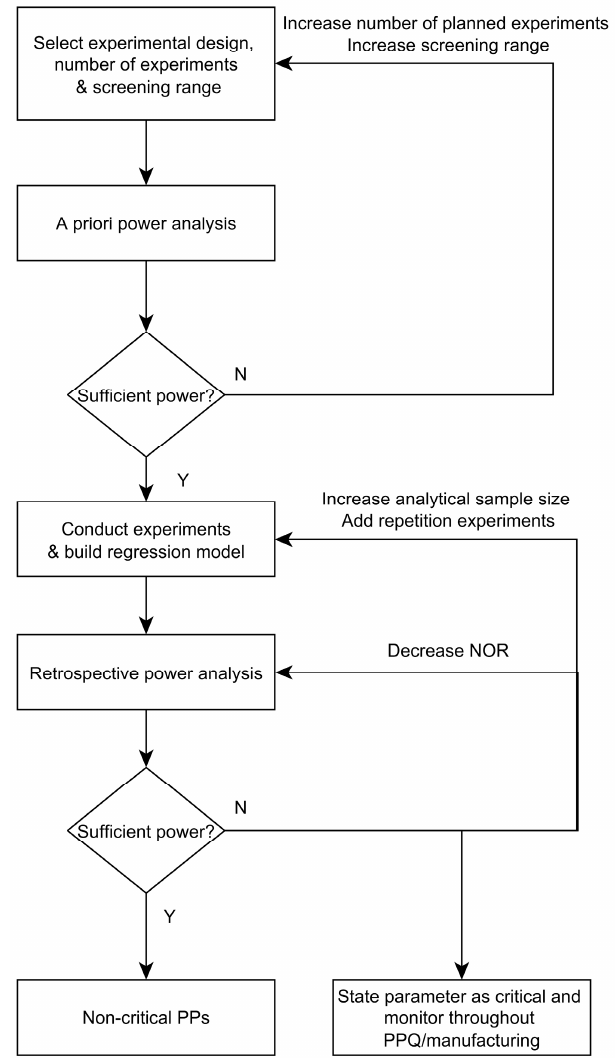
Figure 4. Workflow for criticality assessment of process parameters during process validation stage 1.